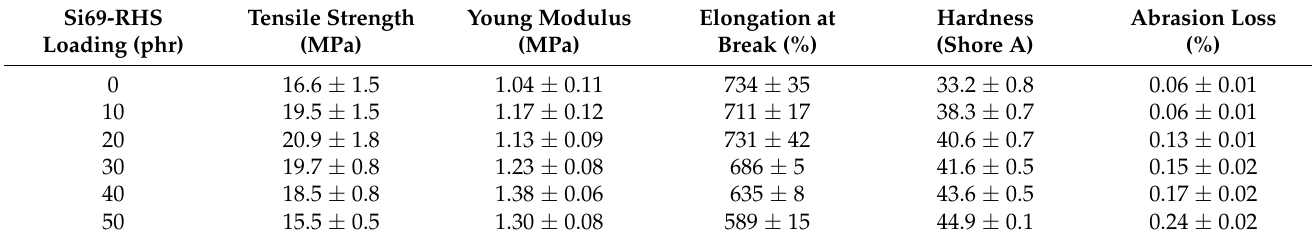
Table 2. Mechanical properties of the NR composites filled with various Si69-RHS loadings.